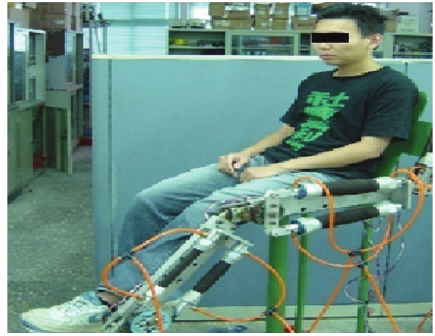
Figure 3: The two-joint leg rehabilitation device with actual human